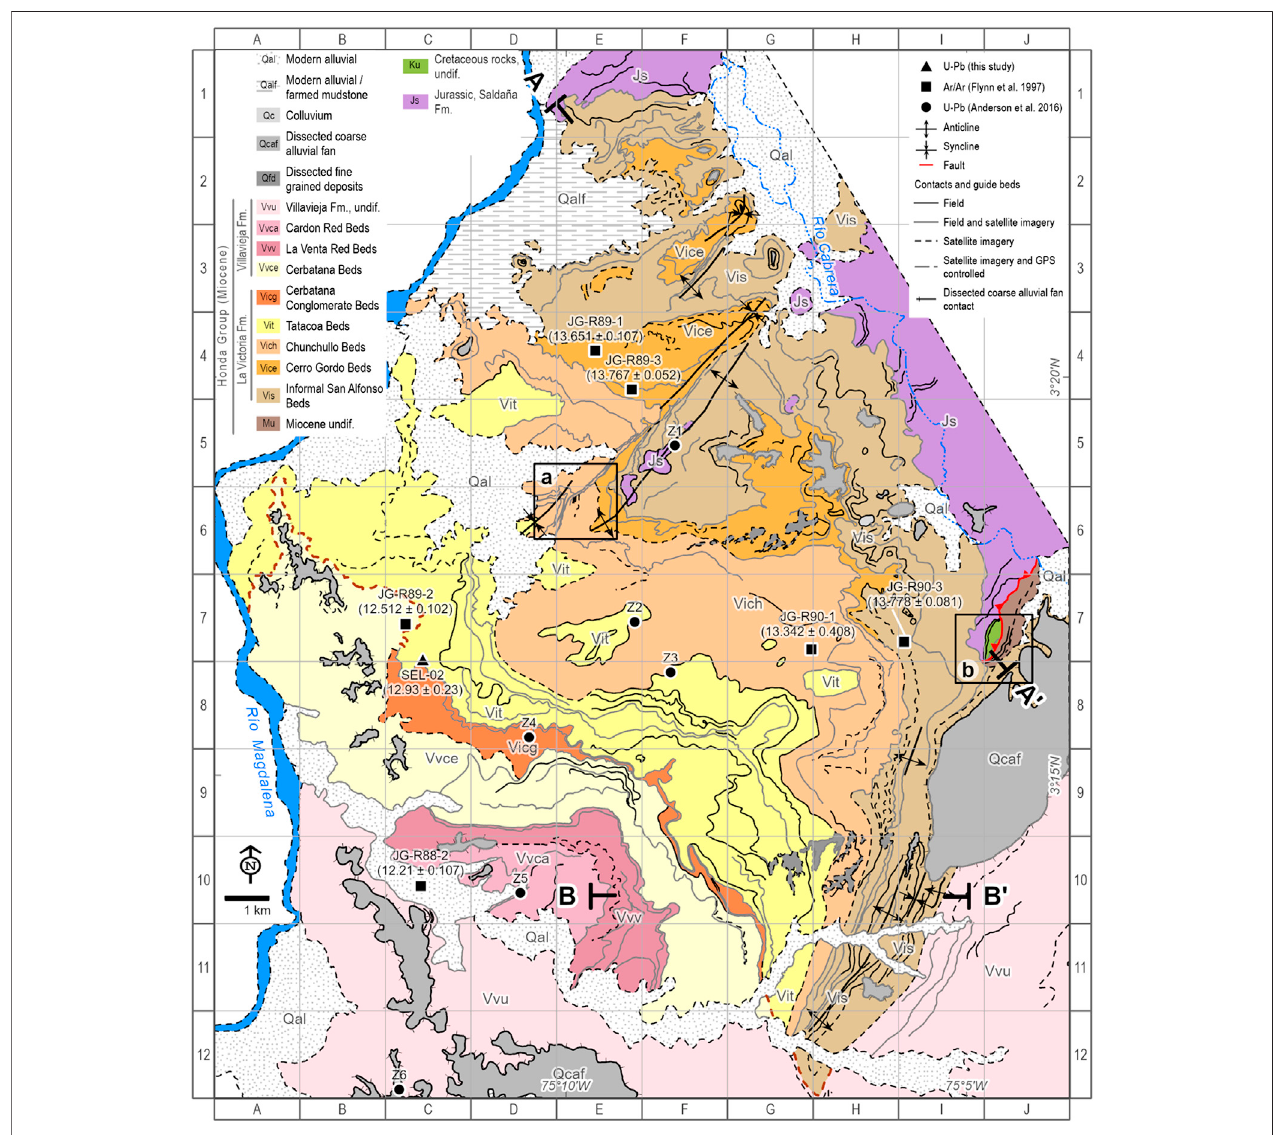
FIGURE 4 | Geologic map of the Tatacoa Desert expanded from original mapping by Guerrero (1993, 1997). The Tataoca Desert is bound to the west by the Magdalena River, to the east by the fi rst ranges of the Eastern Cordillera, to the north by the volcaniclastic outcrops of the Jurassic Saldaña Formation in the Natagaima Arch, and to the south by strata of the overlying Neiva Formation. A larger-scale, printable at 1:25.000 version available of the map also available (Supplementary Figure S1), as well as an electronic .kml version with contacts and data stations in the Supplementary Materials.